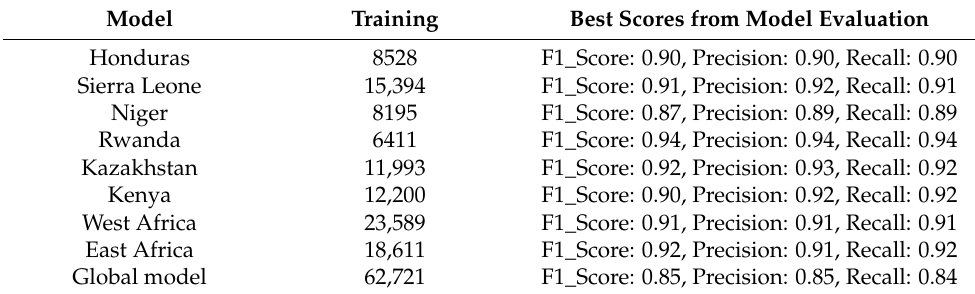
Table 4. Model evaluation metric report for all the tile-based school classifier models.